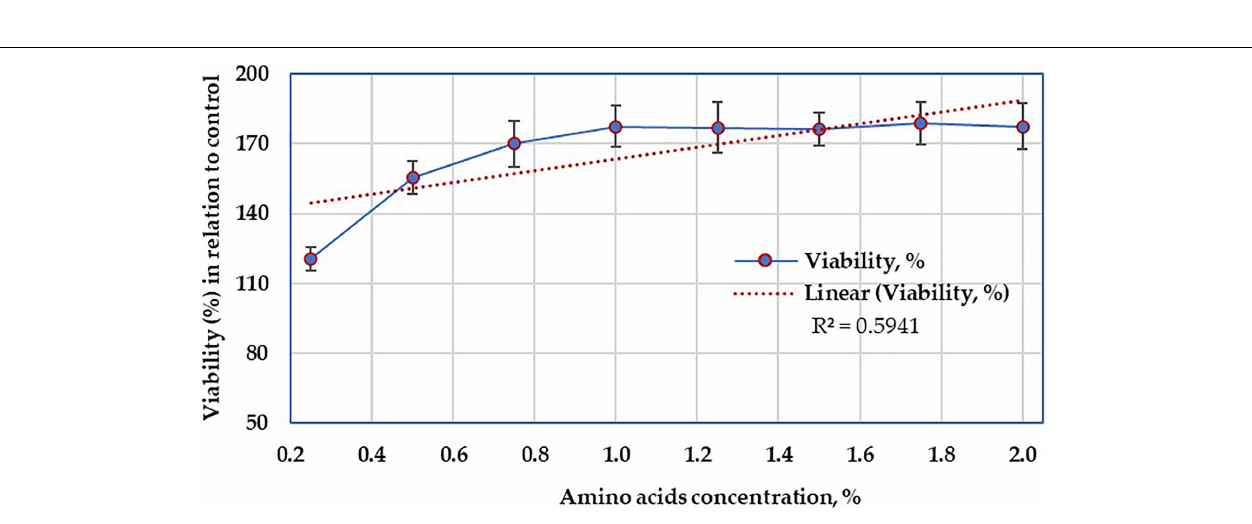
FIGURE 11 | Cytotoxicity test showing the viability of the mammalian cell line in the presence of various concentrations of amino acids.